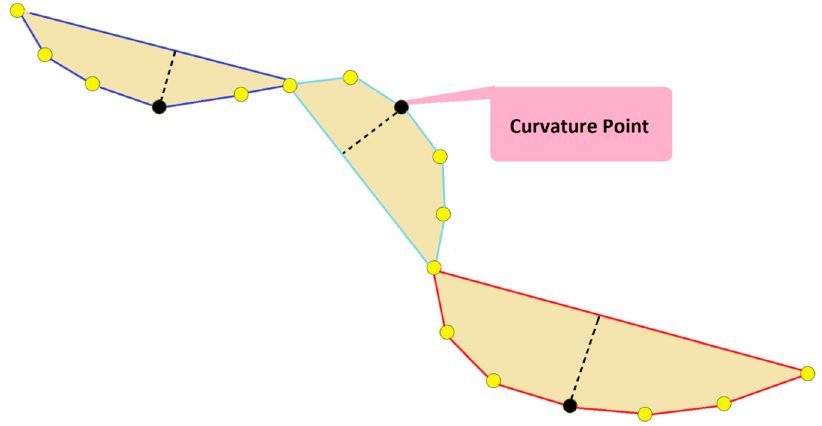
Figure 11. Detecting critical points of a curvature using a convex hull structure.